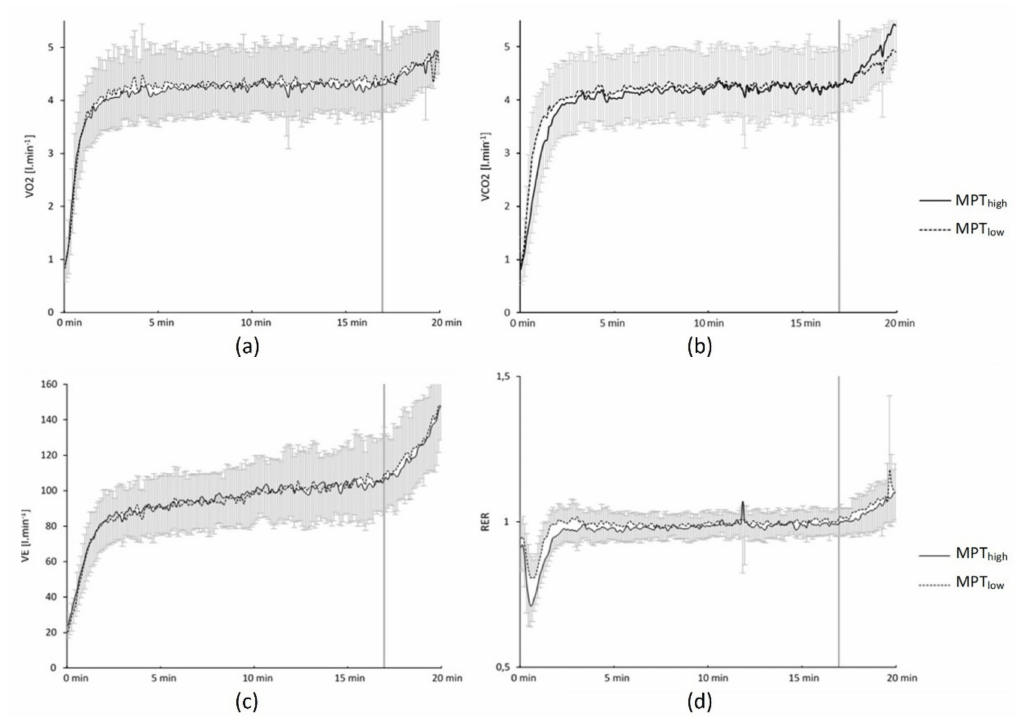
Figure 5. ( a ) Oxygen uptake ( V˙ O 2 ); ( b ) carbon dioxide output ( V˙ CO 2 ); ( c ) ventilation ( V˙ E); ( d ) respiratory exchange ratio (RER), after a usual low intensity warm up (MPT low ) and an additional 25 s all-out arm crank priming pre-load (MPT high